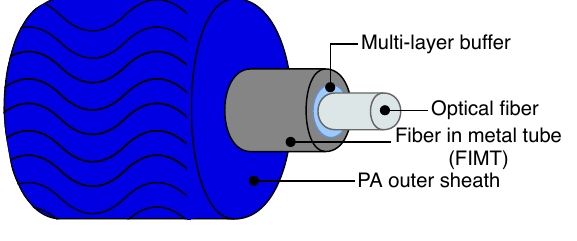
Figure 1. Schematic of the V9 type strain sensing cable, composed by a polyamide sheath of 3.2 mm in diameter, a steel tube (FIMT) of ∼ 0.9 mm in diameter, a multi-layer buffer, which helps the strain transfer, and a single mode fiber (SMF) (250 µ